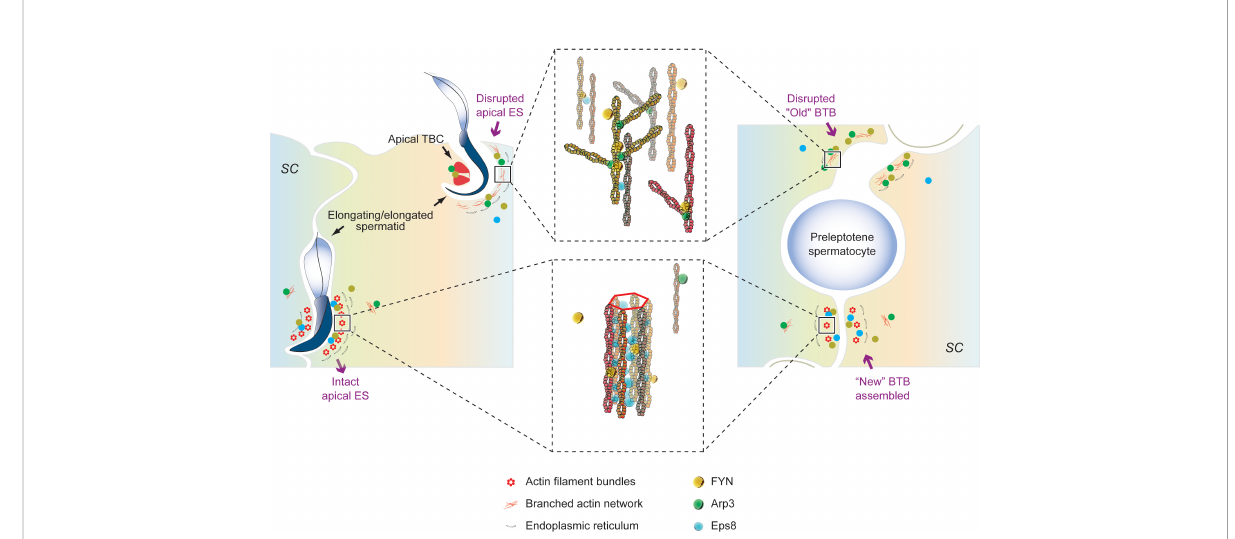
FIGURE 7 An illustration of our proposed working hypothesis in the rodent testes by which FYN, Arp3, and other actin-associated proteins, such as Eps8 and Annexin A2, regulate the apical ES and the BTB to accommodate the transport of spermatids in the seminiferous epithelium, and preleptotene spermatocytes across the BTB from the basal to adluminal compartments, respectively. Bottom left panel: the intact apical ES between elongating spermatids and Sertoli cells is maintained through a network of actin fi lament bundles. This network is created by the actin barbed end capping and bundling protein Eps8, which binds FYN as well. FYN and Eps8 may function together to promote the assembly or integrity of the apical ES (bottom middle panel), which has yet to be clari fi ed. A change in localization and/or distribution of the actin regulatory proteins, Arp3 and Eps8, is observed in stages VII-VIII tubules as elongated spermatids (e.g., step 19 and 16 spermatids in rats and mice, respectively) are about to leave, or after exposure to toxicants such as CdCl 2 . The actin nucleation and branching protein Arp3 interacts with FYN and likely gets phosphorylated and activated. Arp3 promotes the de-bunching of the well-organized F-actin bundles into branched con fi gurations, leading to micro fi lament truncation and retrieval from near the cell surface. In this way, the apical ES is disrupted, rendering